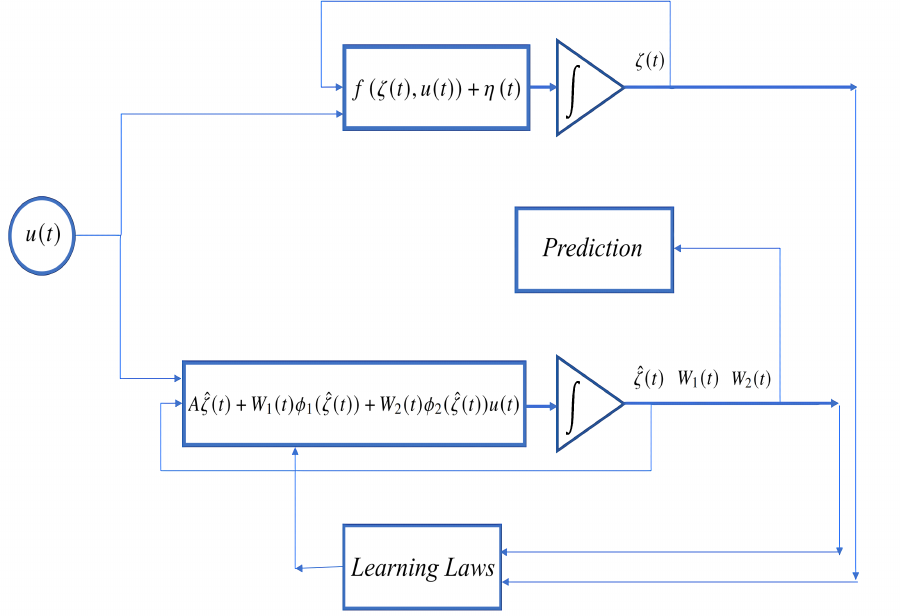
Figure 1. Identification and prediction